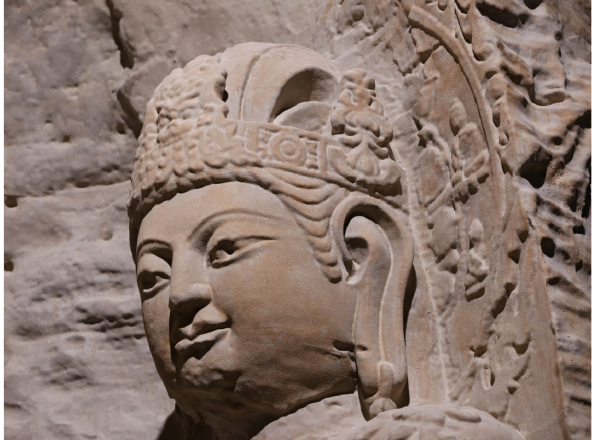
Figure 8. The details of the Replica Cave